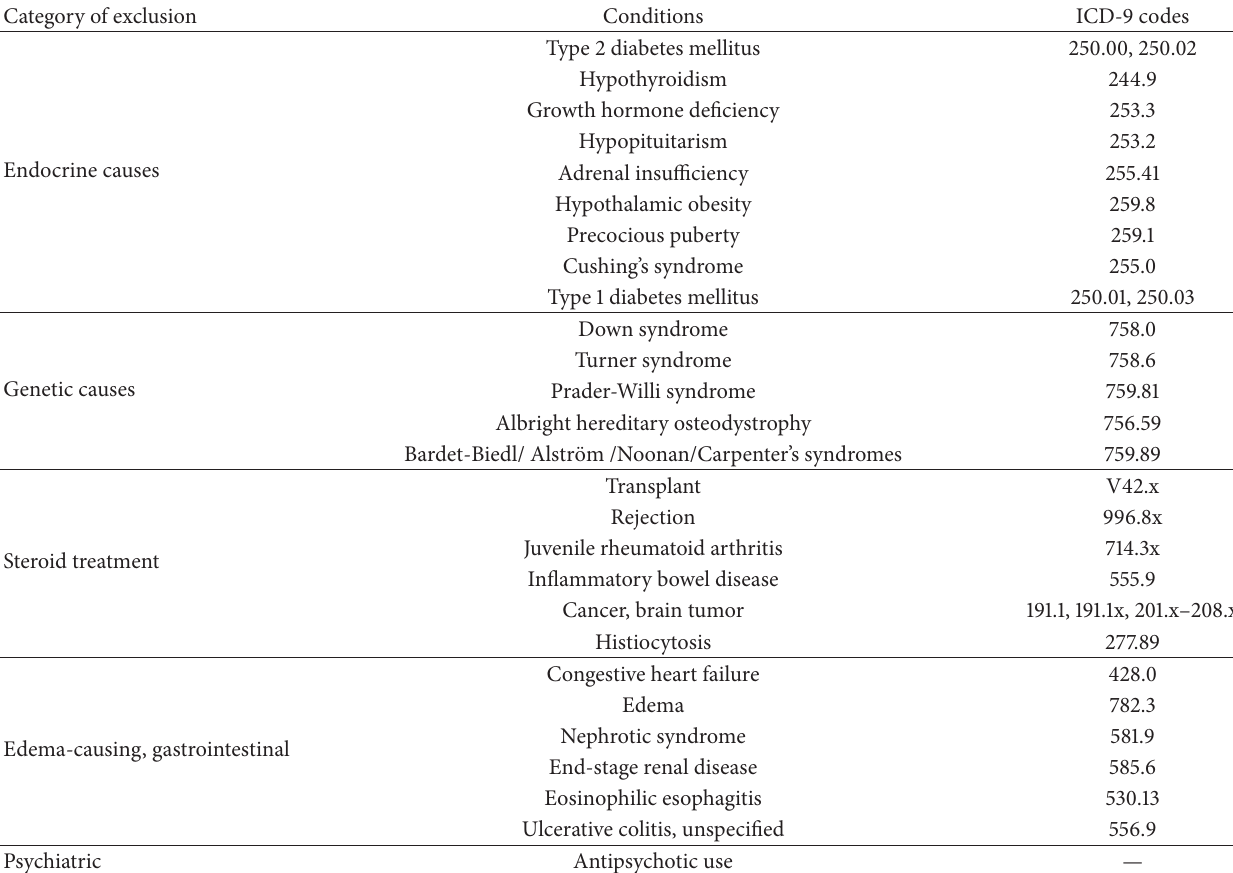
Table 1: Diagnoses excluded from electronic health records (EHR)